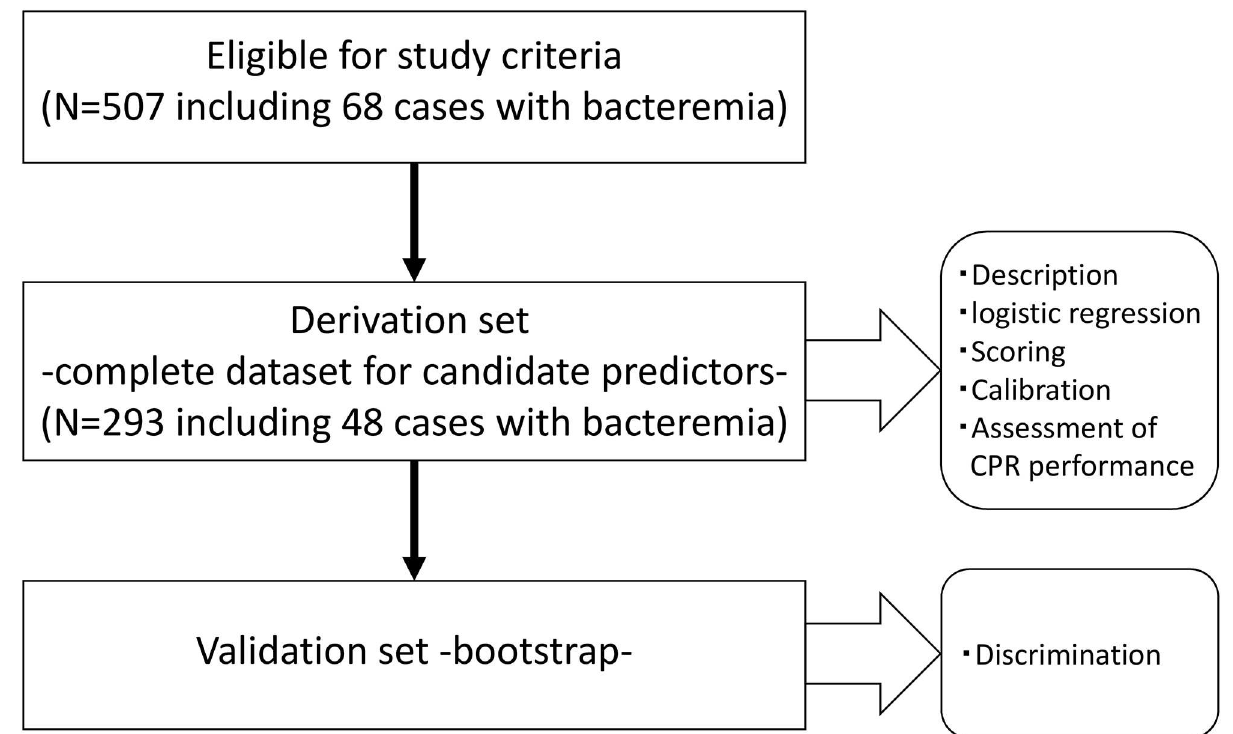
Fig 1. Study flow CPR: clinical prediction